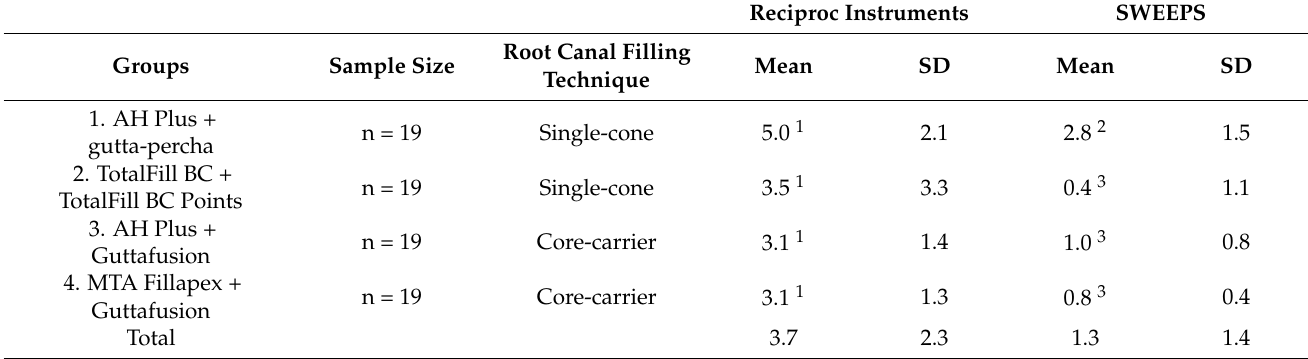
Table 2. Mean values and standard deviation (SD) of the volume (in mm 3 ) of root canal filling remnants, determined by micro-CT analysis, in the four experimental groups after root canal re- treatment with Reciproc instruments and additional SWEEPS